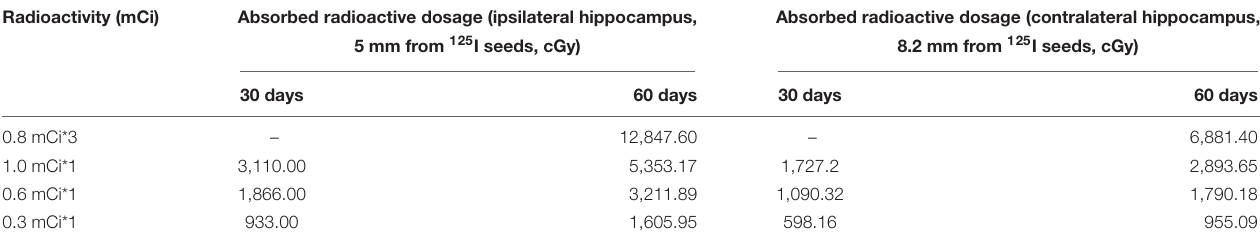
TABLE 1 | Levels of absorbed radioactive dosages in the hippocampus in regions located 5.0 and 8.2 mm from the 125 I seeds. Radioactivity (mCi) Absorbed radioactive dosage (ipsilateral hippocampus, Absorbed radioactive dosage (contralateral